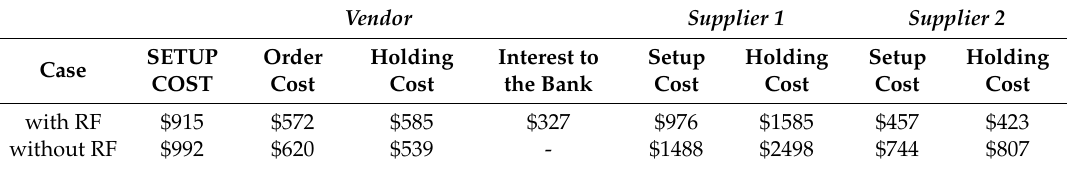
Table 3. Analysis of the di ff erential costs with and without a reverse factoring agreement. Vendor Supplier 1 Supplier